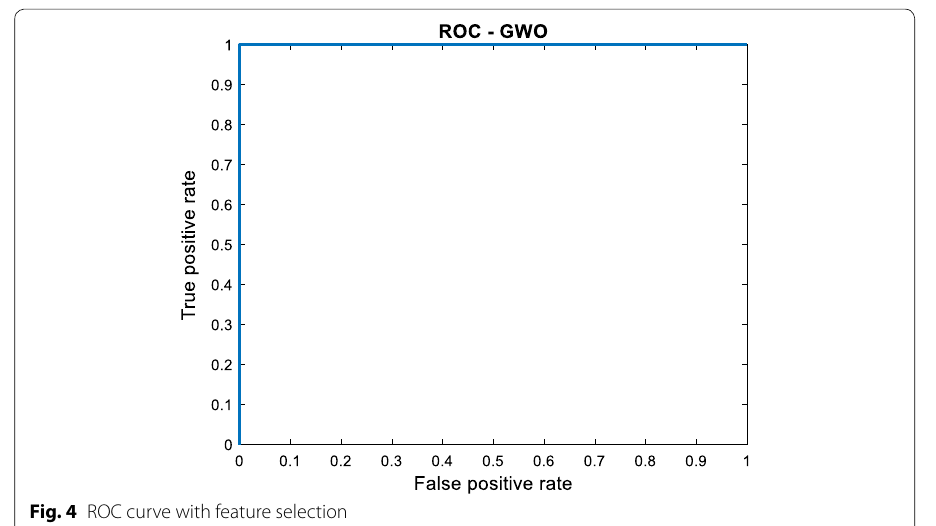
Fig. 4 ROC curve with feature selection